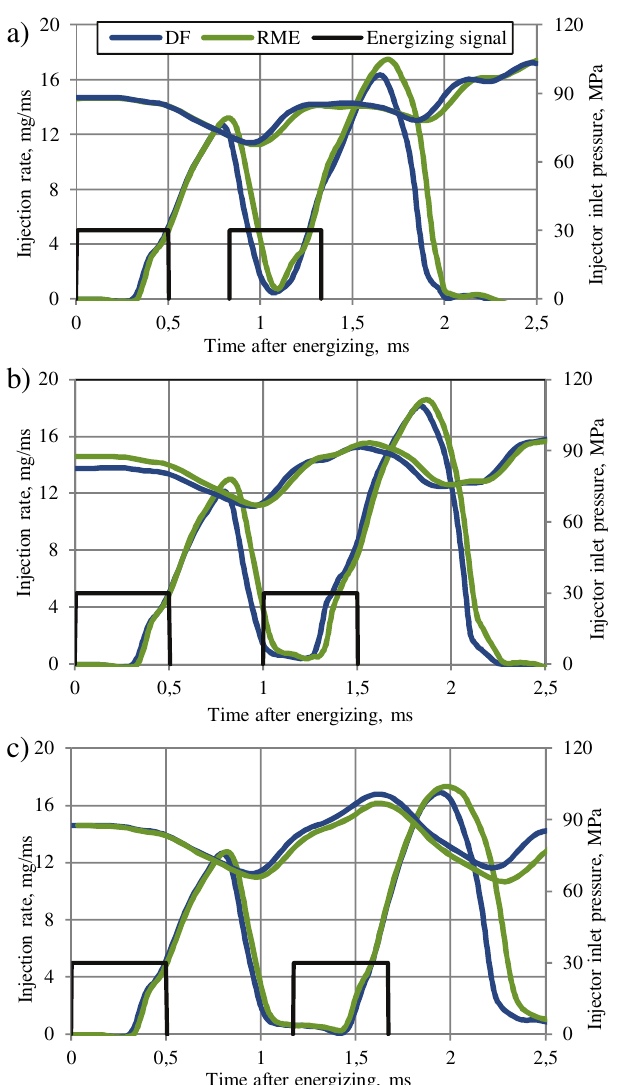
Fig. 3. Effects of fuel types on injector inlet pressure and the injection rate under split injection at the intervals: a – 0.8 ms, b – 1.0 ms, c – 1.2 ms